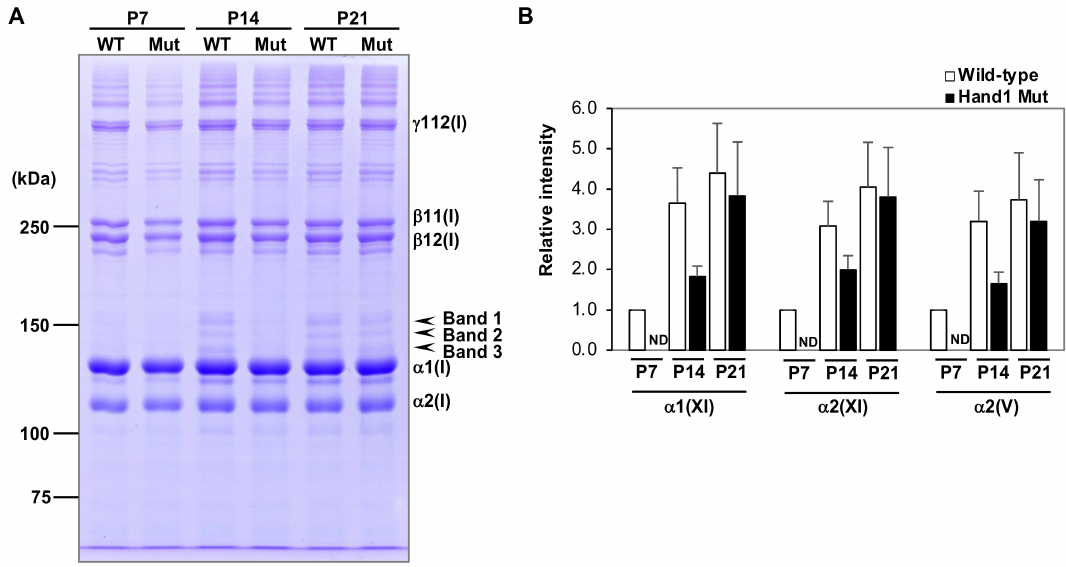
Figure 4. SDS-PAGE analysis of purified collagen samples. ( A ) The relative expression of collagen chains purified from the cortical bones from wild-type (WT) and Hand1 -overexpressing (Mut) mice at postnatal day 7 (P7), P14, and P21 was evaluated by SDS-PAGE. The gel bands 1–3 (arrowheads) were identified as alpha 1(XI), alpha 2(XI), and alpha 2(V), respectively (Table S5). The expression of alpha 1(XI), alpha 2(XI), and alpha 2(V) (arrowheads) in the cortical bones of wild-type mice (WT) increased during postnatal development. This increase was delayed following continuous expression of Hand1 in the osteochondral progenitors (Mut). Shown is a representative SDS-PAGE image from three independent experiments. ( B ) Changes in the levels of gel band intensity of alpha 1(XI), alpha 2(XI), and alpha 2(V) are represented as mean ± S.E.M. ( n = 3). ND, not